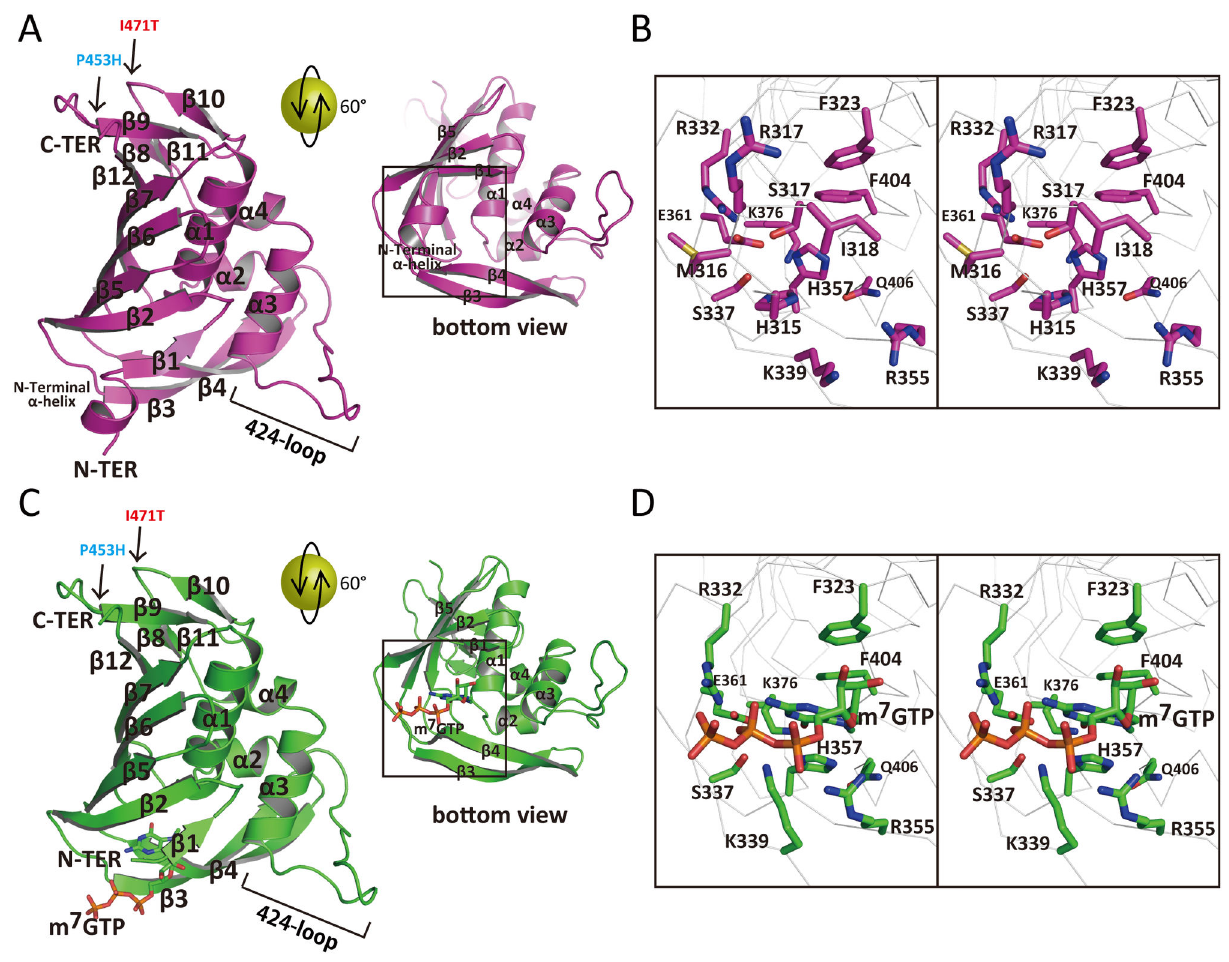
Figure 1. Crystal structure of PB2 middle domain (amino acids 318 to 483) of H1N1 from human influenza A virus with or without m 7 GTP. A) Crystal structure without m 7 GTP in magenta. Left panel is the overall structure. Right panel is the same model as left panel but rotated by 60° about a horizontal axis to show the active site. Secondary structures are labeled in black and two mutations P453H and I471T are indicated by arrows with blue and red labels, respectively. B) Close-up view of the square of panel A in stereo view. Main chain is represented by white ribbon. Residues of active site and N-terminal helix are labeled in black. C) Crystal structure with m 7 GTP in green. Left panel is the overall structure. Right panel is the same model as left panel but rotated by 60° about a horizontal axis to show the active site. m 7 GTP is represented by stick model. Secondary structures are labeled in black and two mutations P453H and I471T are indicated by arrows with blue and red labels, respectively. D) Close-up view of the square of panel of C in stereo view. Main chain is represented by white ribbon. Active site residues are labeled in black. H357, F404, E361 and K376 formed the active site cleft to bind to 7-methyl-guanine. Triphosphate interacts with R332, S337, K339, R355 and E361. doi: